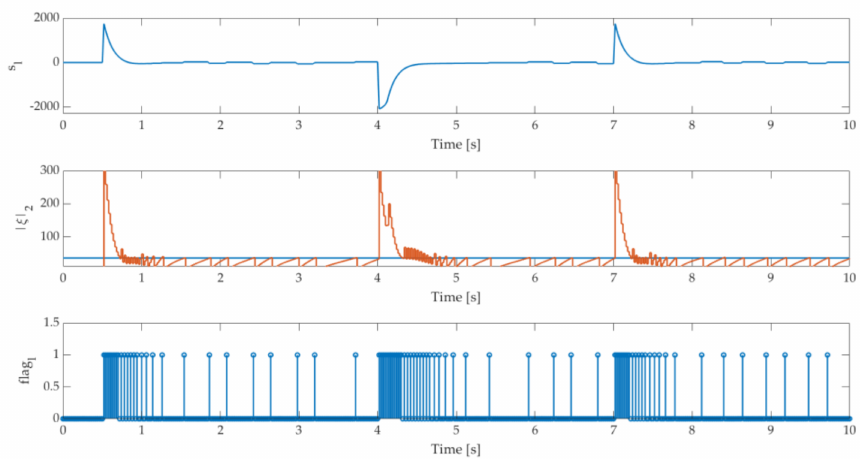
Figure 5. ET sliding variable evolution s l with triggering condition ξ and update flags of the closed- loop system with the controller u l .